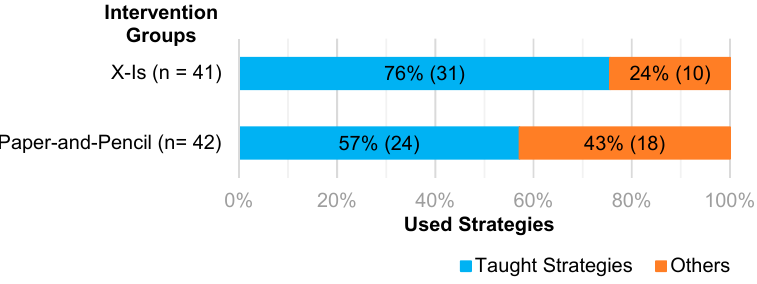
Figure 9. Percentage (number of cases in parentheses) of different strategies used to solve equations correctly on the test by instructional condition.